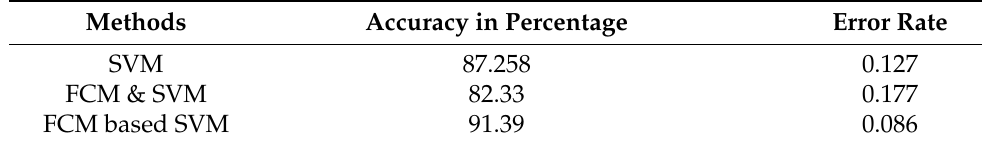
Table 5. Performance evaluation and